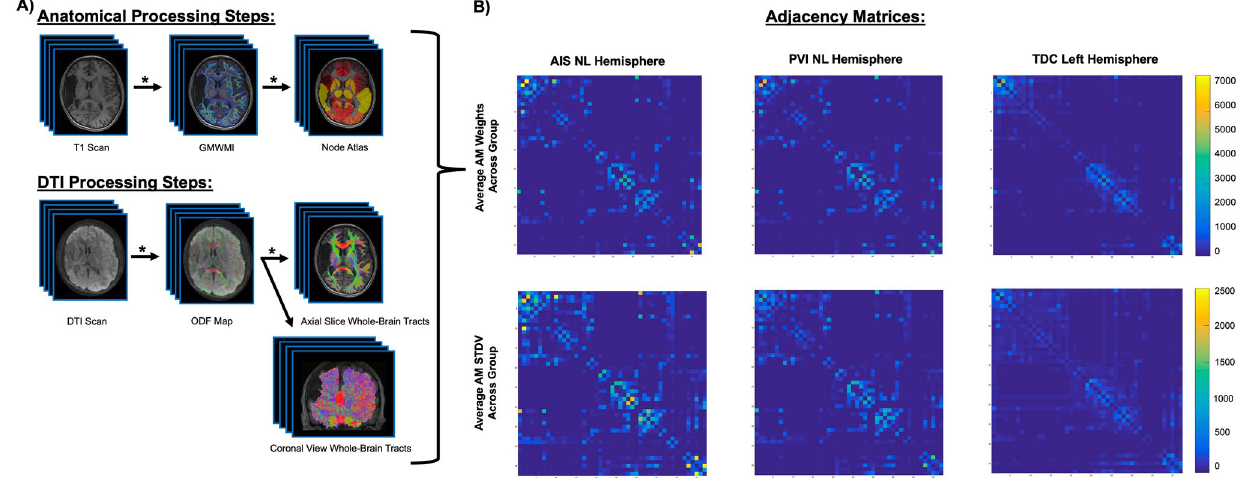
Figure 1. Neuroimage processing steps. ( A ) Anatomical images were segmented based on tissue type and combined to create a gray matter-white matter interface (GMWMI) image. The AAL2 atlas (node atlas) was co-registered into patient diffusion space. For DTI images, eddy currents and small head motion was corrected. ODF maps were then generated and whole-brain tracts were reconstructed (restricted to only white matter using the GMWMI image) and seeded using the co-registered node atlas to generate an undirected 47 × 47 node adjacency matrix containing number of streamlines between node pairs (network weights). Network weights in the non-lesioned hemispheres were compared between groups of children with perinatal stroke (AIS, PVI) and the left hemisphere in controls. Asterisks highlight steps where quality assurance was performed by two authors. ( B ) Group average adjacency matrices for AIS, PVI and TDC participants as well as matrices containing standard deviations to visually illustrate variances between the groups. Images in ( A ) were generated using MRTrix3 (https:// www. mrtrix. org/) and images in ( B ) were generated using MATLAB (https:// www. mathw orks. com/ produ cts/ matlab. html). DTI diffusion tensor image, ODF orientation density function, AIS arterial ischemic stroke, PVI periventricular venous infarction, TDC typically developing matter interface image, review of the tractography, and finally the review of the atlas parcellation registration to the patient’s brain (Fig. 1, denoted by asterisks). Structural matrix processing. A whole brain, undirected 120 × 120 adjacency matrix was generated using MRTrix3’s tck2connectome. The number of streamlines that entered any ROI were used as network weights. Small sub-cerebellar ROIs were subsequently excluded and the non-lesioned hemisphere was isolated leaving a 47 × 47 ROI matrix where the matrix diagonal was set to 0 5 . In controls, streamlines in the left ‘dominant’ hemisphere were used for comparison. The metrics mentioned below were extracted for the whole hemisphere as well as a subset of sensorimotor-related nodes identified using the AAL2 atlas. These nodes included the primary motor cortex (M1), primary somatosensory cortex (S1), supplementary motor area (SMA), thalamus, caudate, putamen, pallidum and one negative control node (inferior occipital gyrus, IOG) to establish func- tional specificity 20 . Density-based thresholding removed the bottom 25% of weights in each adjacency matrix to exclude spurious reconstructed fibres. Null, or randomized graphs, were generated by creating a randomized 47 × 47 matrix using the Erdös-Renyi algorithm 21 . Based on an average of each group’s sample size, 28 null graphs were generated for comparison. Graph theory outcomes. General terminology. Graph theory definitions are explained graphically in Fig. 2. A node is defined as an atlas-based region of interest, such as the thalamus or M1. An edge is the connec- tion that joins one node to another. Degree is defined as the number of edges associated with a given node. For example, if a node has 4 edges, it is connected to 4 other nodes and has a degree of 4. A path is defined as a finite sequence of distinct edges and nodes that join together two nodes of interest, such as the red arrows in Fig. 2A. A neighborhood is the set of nodes who are a path length of 1 away from a node of interest. Betweenness centrality. Betweenness centrality assesses how ‘central’ a node is to the network 22 . For example, in Fig. 2A, node G has a high betweenness centrality since any path between nodes O, B, Y, and T all must go through G. Nodes O, B, Y, and T are nodes of degree 1 (only one edge), also called leaf nodes. Thus, no path between any two nodes would pass through them in the network, resulting in a betweenness centrality of 0. Betweenness centrality for a node is defined below, where ρ is the number of shortest paths between h and j, and ρ hj is the total number of shortest paths between h and j that pass through node i 22 :